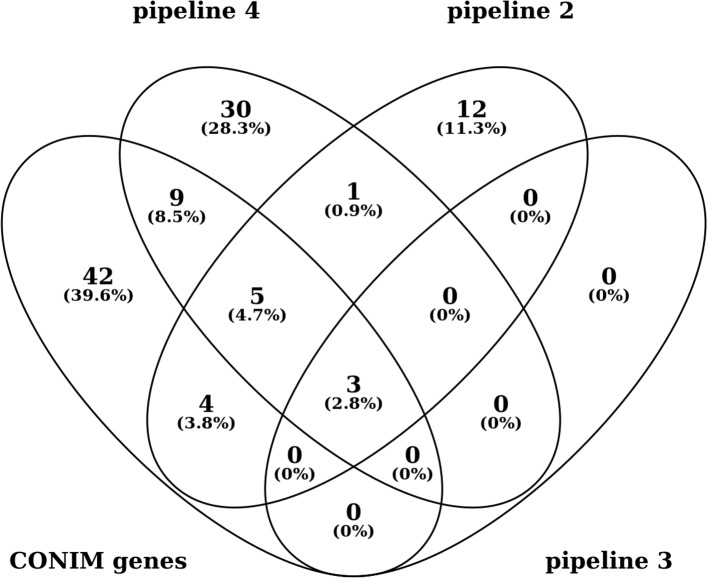
DOI:
http://dx.doi.org/10.7554/eLife.16519.015